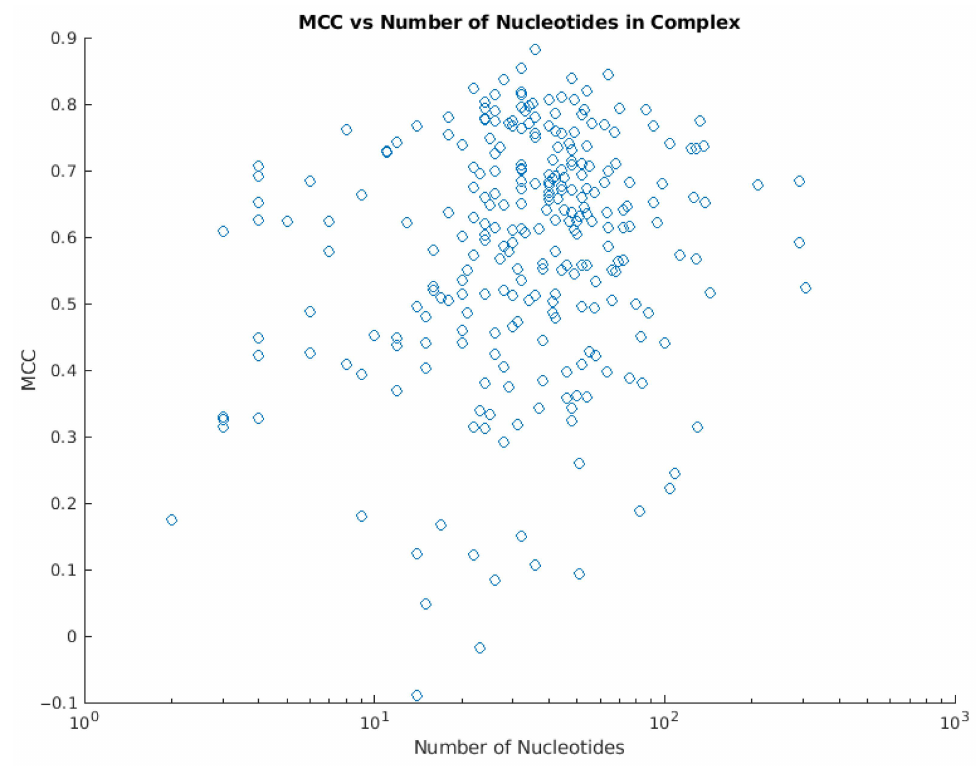
Figure 1. The relationship between the number of binding nucleotides and the MCC value of each